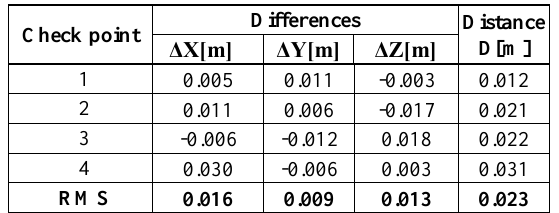
Table 1: The residuals of the artificial CPs after georeferencing the point cloud using the minimum number of control points The RMS (Root Mean Square) values along the axis and cumulative were calculated: RMS along the X axis (0.016 m), RMS along the Y axis (0.009 m), RMS along the Z axis (0.013 m), spatial RMS (0.023 m).